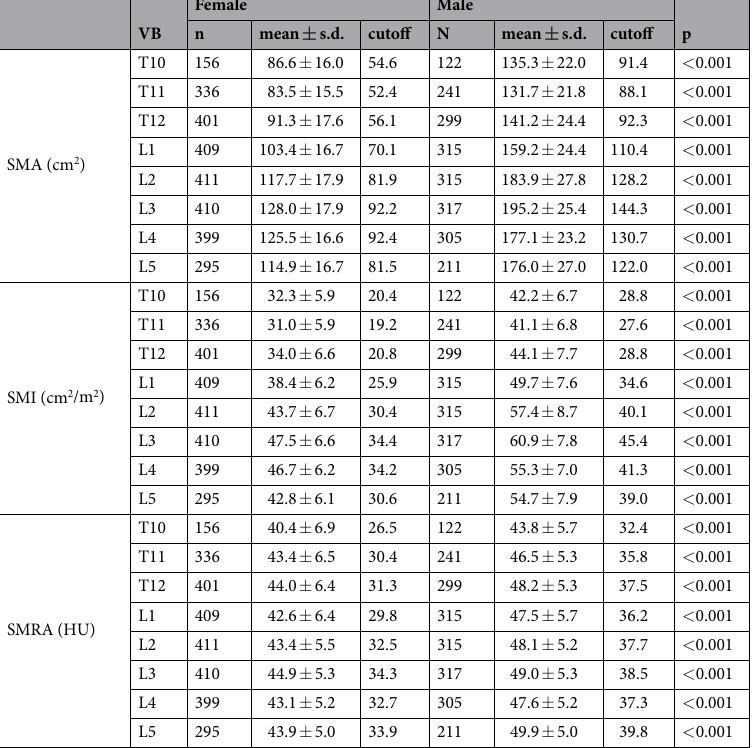
Table 2. Sex-specific healthy reference values for T10-L5 SMA, SMI, and